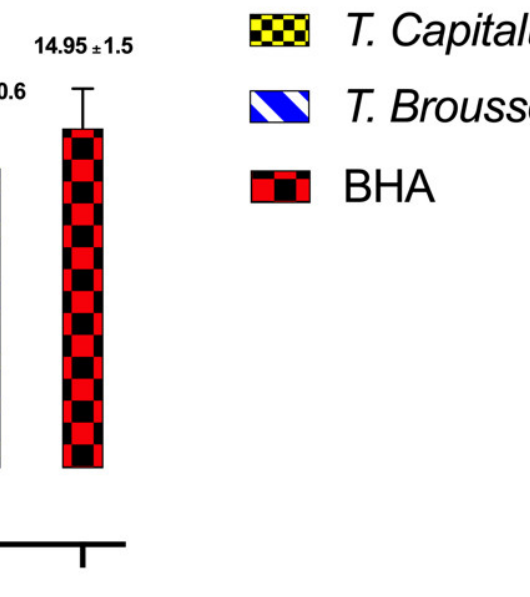
Figure 4. Total antioxidant capacity (Abs. at 695 nm) of T. capitatus and T. broussonetii essential oils; with the regression curve of ascorbic acid. Data are expressed as mean ± SD. The experiment was performed in a minimum of three replicates.